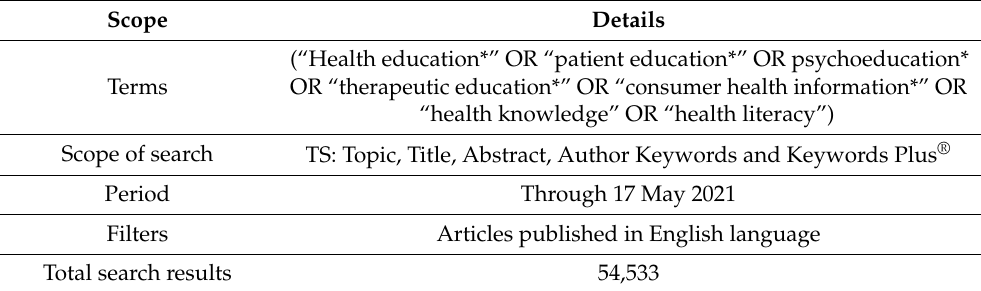
Table 1. Search strategy to identify studies pertaining to patient education